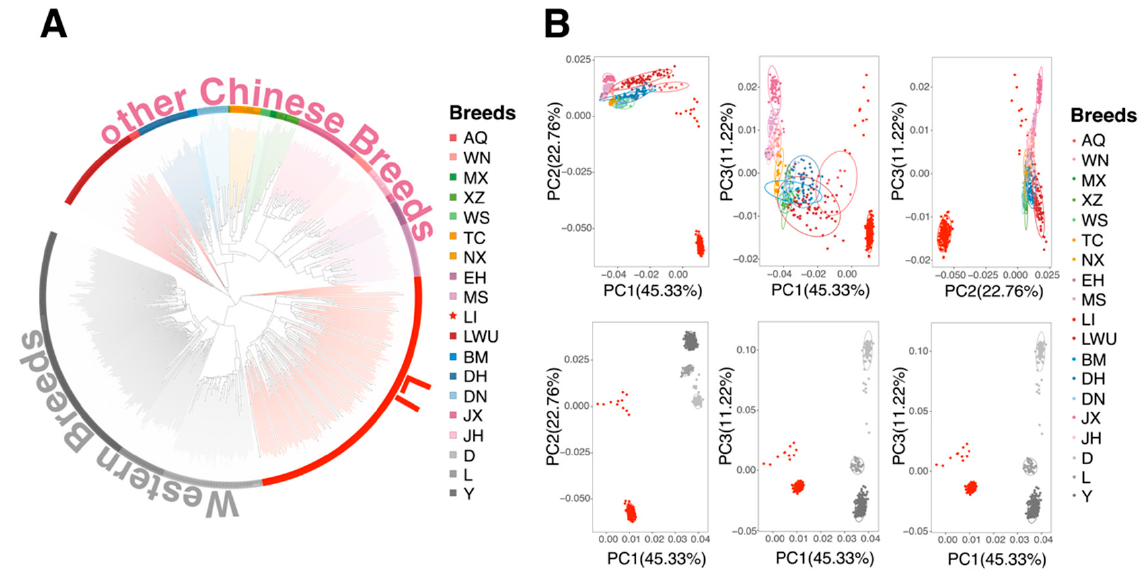
Figure 2. Population relationship and structure. ( A ) NJ-tree based on an identical-by-state matrix among 891 pigs tested in this study. Each abbreviation represents a pig breed, and each color represents an ecotype (Table S1). ( B ) Principal component analysis of Licha black (LI) pig and other Chinese breeds (up) and PCA of Licha black pig and foreign Chinese breeds (down). Each figured point represents the eigenvector of one individual. The first (PC1), second components (PC2), and third components (PC3) are shown.